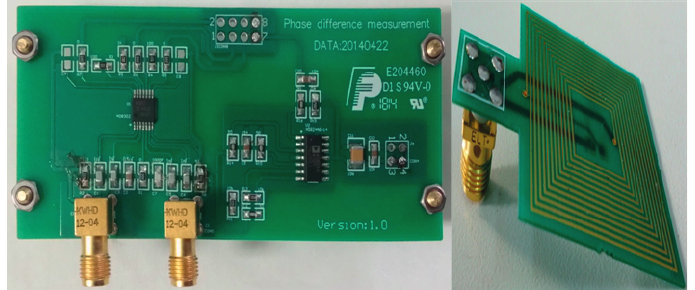
Figure 6. The prototype of the analogy fronted circuit and reading antenna for phase difference